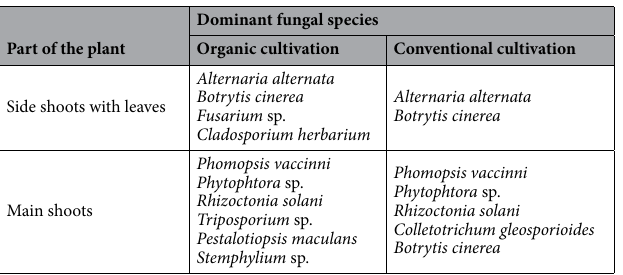
Table 2. Differences in the mould composition from the leaves and shoots of the highbush blueberry, depending on the method of cultivation.